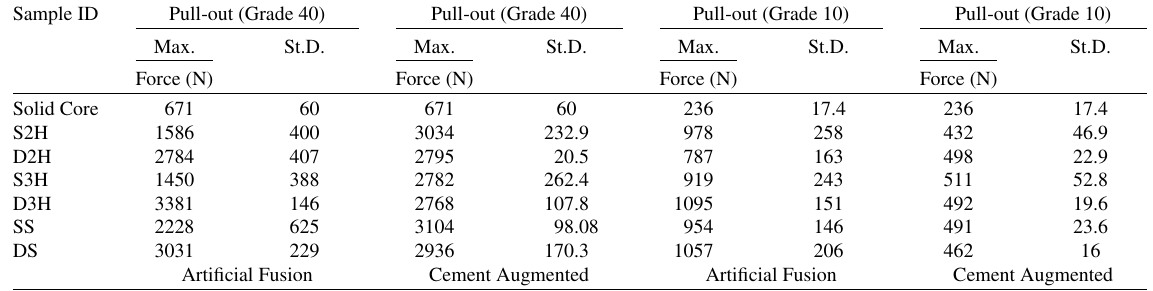
Table 3 Pull out test results. Comparison table of artificial fusion and cement